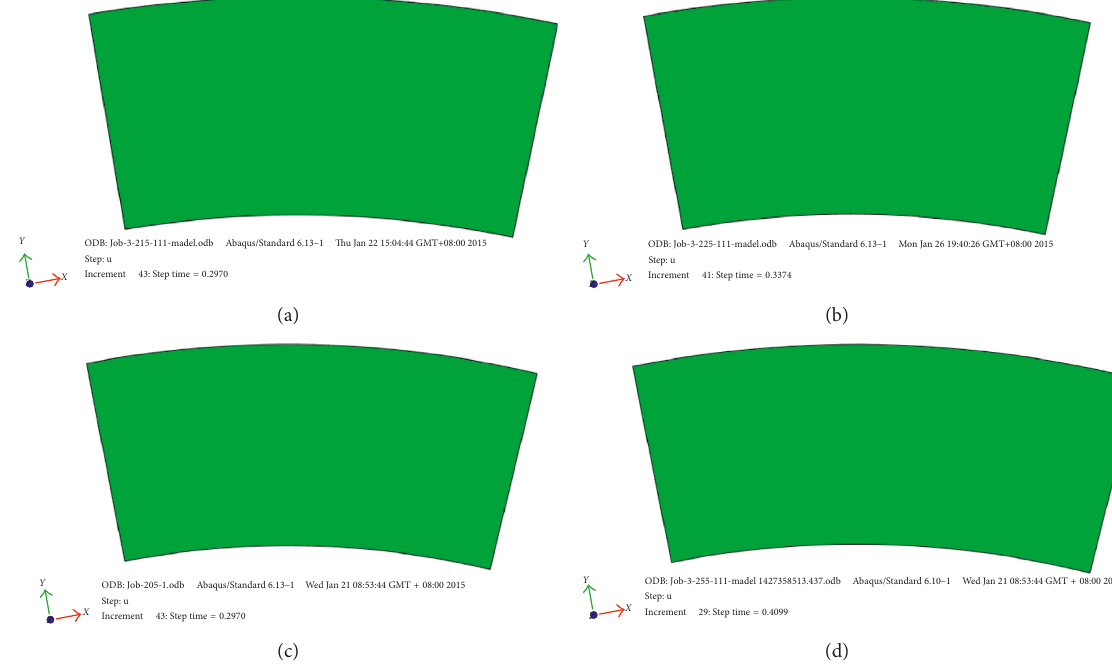
Figure 22: Sectional view of different sizes of the wedge-shaped part of the joint: (a) β